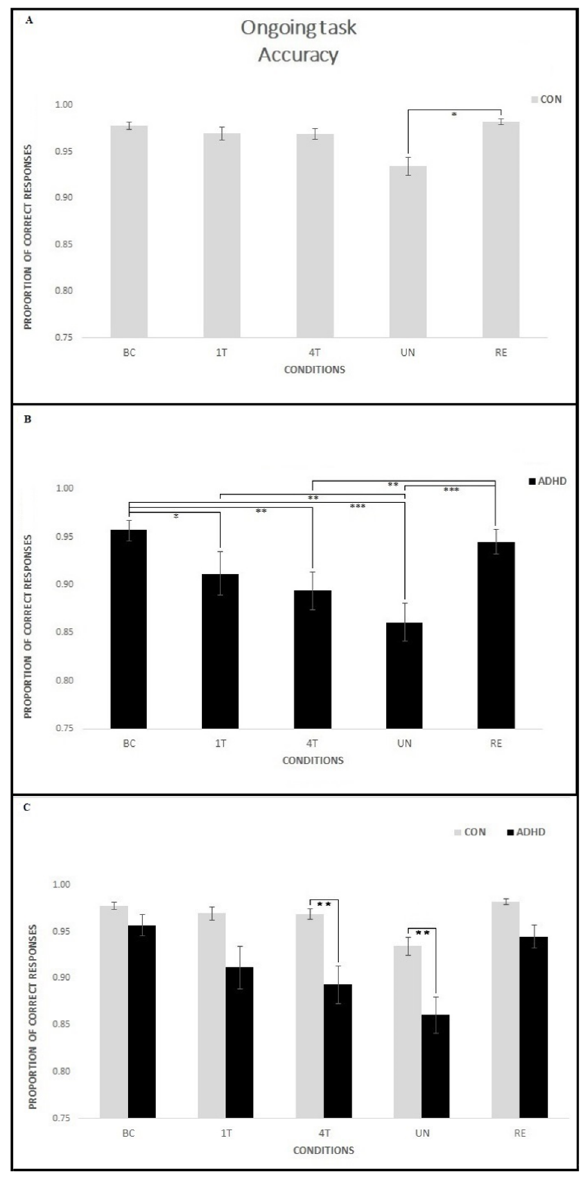
Figure 6. Accuracy on the ongoing task for each condition in the two groups. Within-group com- parisons showed that in the CON group (Panel 6 A ) no significant difference emerged between BC and all the PM conditions; the accuracy on the UN was lower than the RE condition. Conversely, participants in the ADHD group (Panel 6 B ) showed lower accuracy in almost all the PM condi- tions compared to BC. 4T and UN conditions were lower than 1T and RE. Between-group compar- isons (Panel 6 C ) showed that the ADHD group performed significantly lower than the CON group on the 4T and UN conditions, while no difference emerged on the BC, 1T, and RE condi- tions. Asterisks mark significant differences: * p < 0.05, ** p < 0.01, *** p < 0.001.